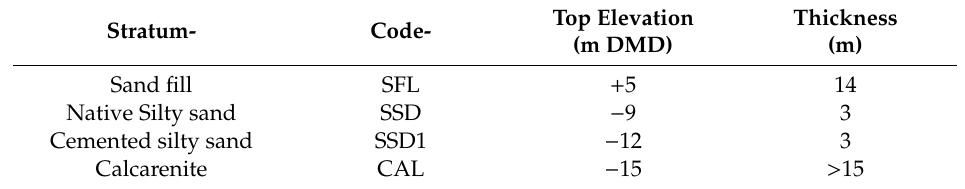
Table 2. The ground model with elevations of the rockfill and the underlying natural ground profile. Top Elevation Thickness Stratum- Code- (m DMD) (m) Sand PRM + 5 1 Rockfill RFL + 4 13 Silty sand SSD − 9 3 Cemented silty sand SSD1 − 12 3 Calcarenite CAL − 15 > 15 Table 3. The ground model with elevations of the sand fill and the underlying native ground profile. Top Elevation Thickness Stratum- Code- (m DMD) (m) Sand fill SFL + 5 14 Native Silty sand SSD − 9 3 Cemented silty sand SSD1 − 12 3 Calcarenite CAL − 15 >